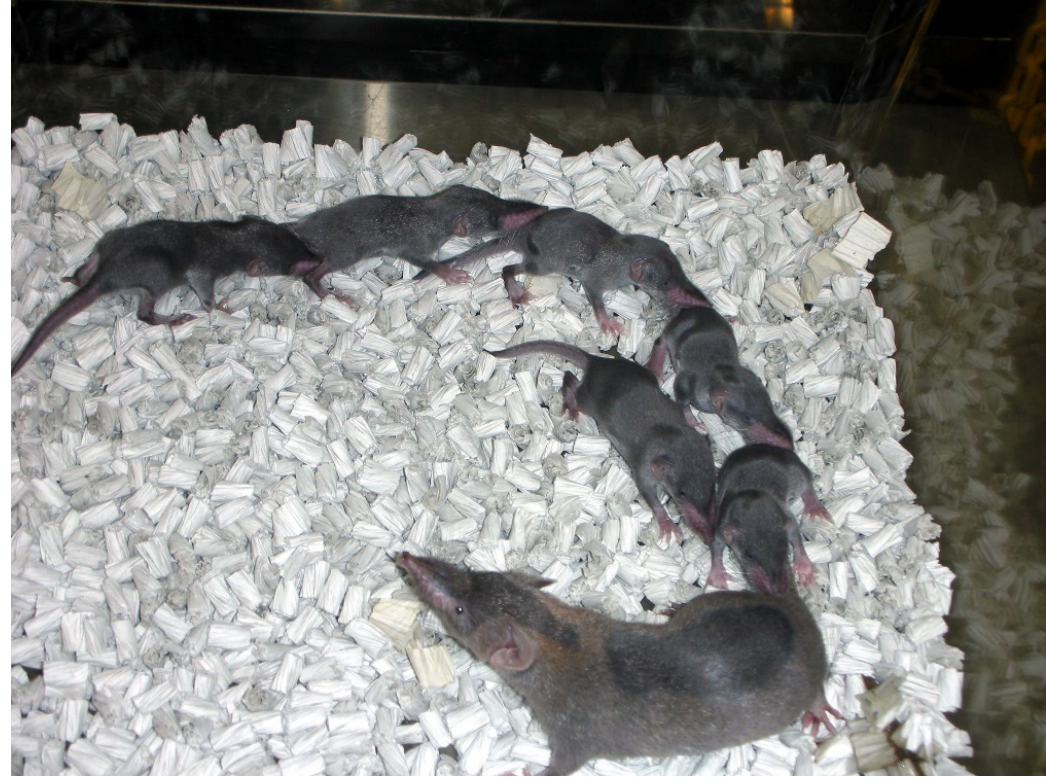
Figure 1. The outbred colony of Suncus murinus. Table 1. Physiological and metabolic data in Suncus murinus .